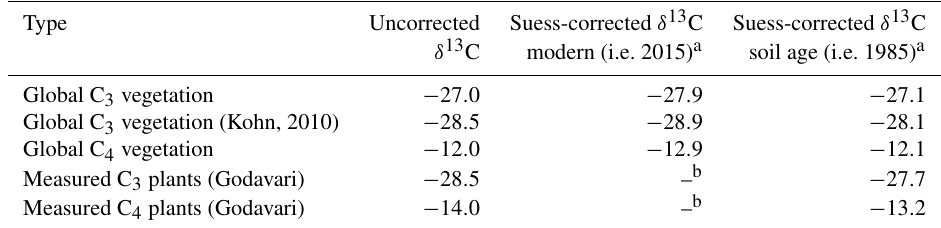
Table 1. Suess correction of plant δ 13 C values.